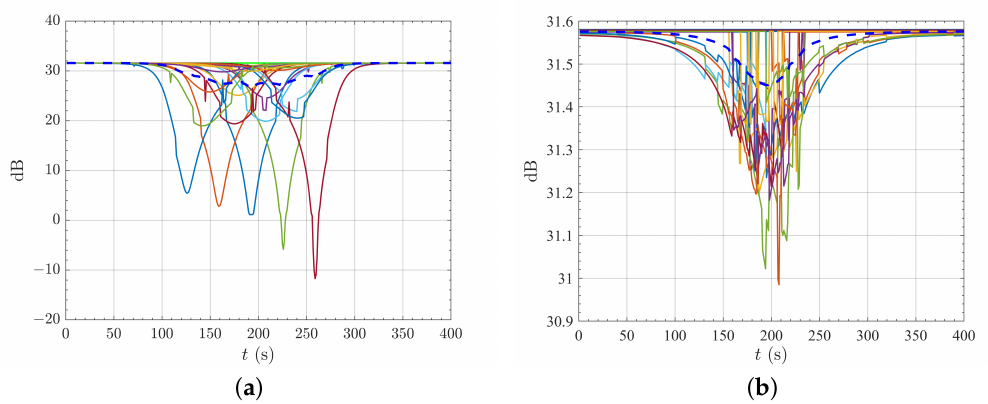
Figure 11. SNR and SINR of different GSO ground stations in different beams for the 19-beam scenario without and with channel allocation. ( a ) SNR and SINR of different GSO ground stations in different beams for the 19-beam scenario without channel allocation; ( b ) SNR and SINR of different GSO ground stations in different beams for the 19-beam scenario with channel allocation.